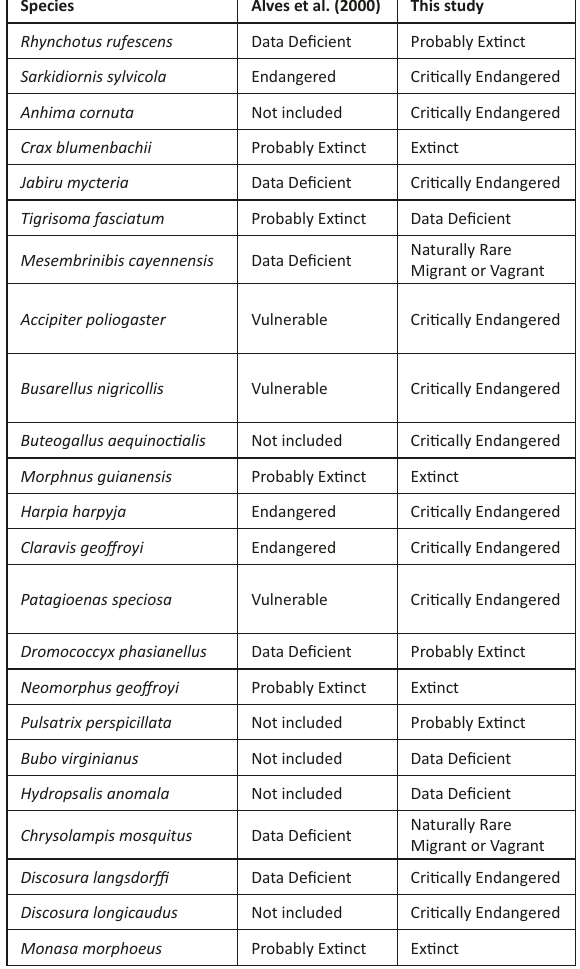
Table 4. The rarest bird species in the state of Rio de Janeiro for which the local conservation status has been changed in the present study. Species Alves et al.